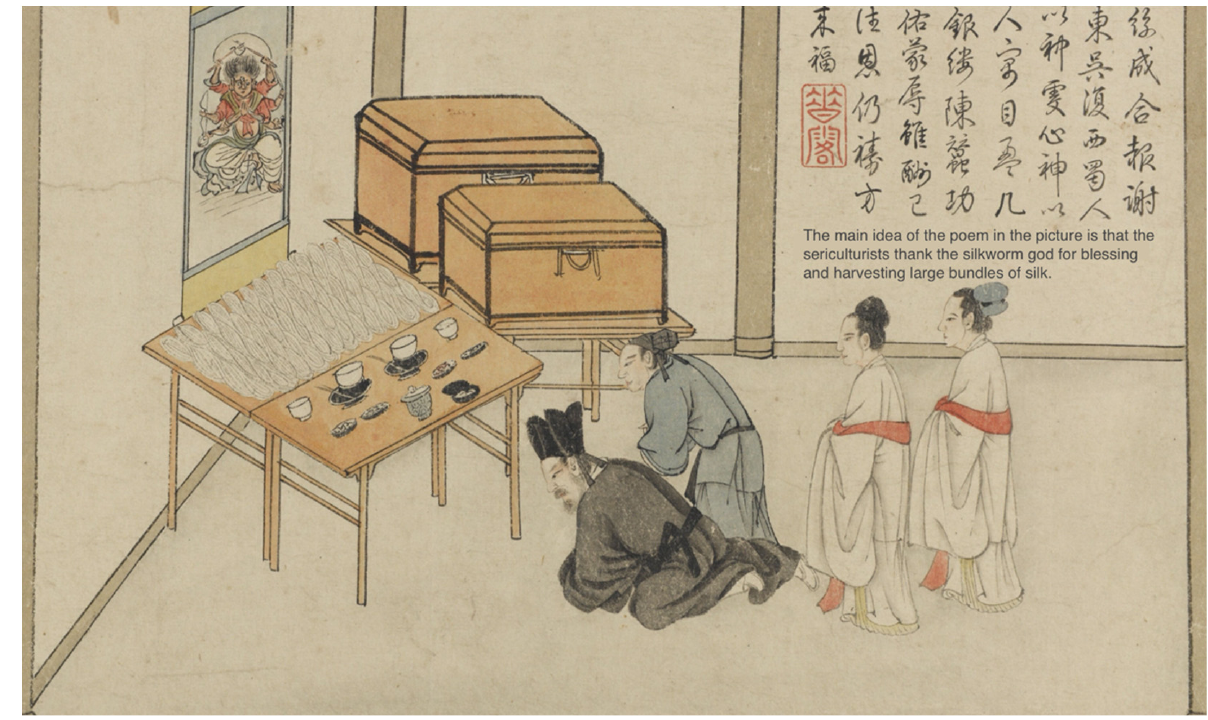
Figure 5. Part of “A picture of Farming and Weaving 耕织图 ”, Yuan Dynasty (1271–1368). Held by the Sackler Museum. Photo Source: official of Shuge 4 .